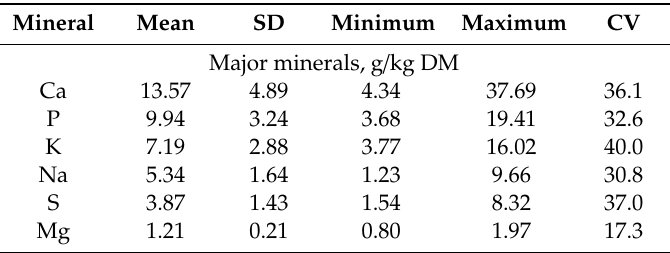
Table 3. Mineral composition (dry matter basis, DM) of extruded dry dog food samples ( n = 119) included in the present study quantified with inductively coupled plasma optical emission